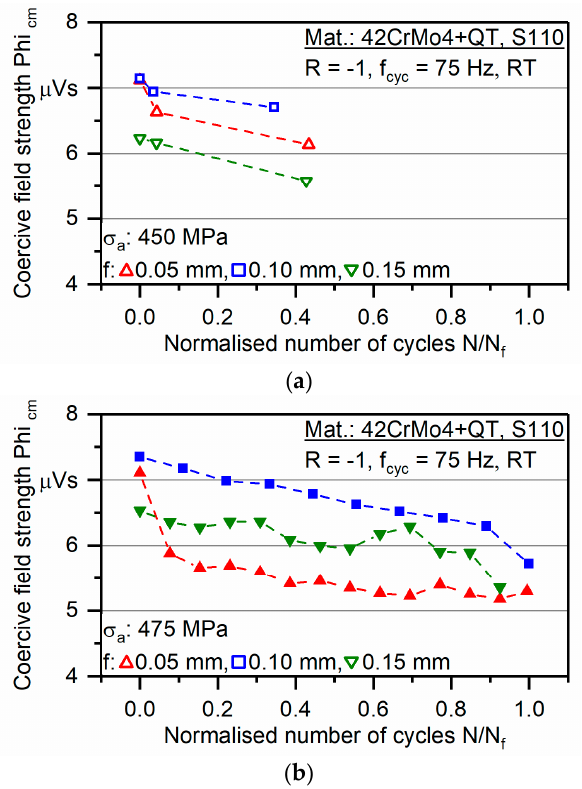
Figure 12. Coercive field strength versus the normalised number of cycles for constant amplitude tests with S110 specimens and amplitudes ( a ) 450 MPa; ( b ) 475 MPa. When the coercive field strength is also normalised on the 10 4 cycles value, a quadratic relationship between the coercive field strength and the proceeding fatigue damage can be observed for all investigated load amplitudes and all feed rates, whereby the best correspondence can be seen for the feed rates 0.05 mm and 0.10 mm. This relationship can be described with the following Equation (1): (cid:2870) (cid:3017)(cid:3035)(cid:3036) (cid:3278)(cid:3288) (cid:3017)(cid:3035)(cid:3036) (cid:3278)(cid:3288),(cid:3117)(cid:3116)(cid:3120) = 1 − 0.174 (cid:3015) (cid:3015) (cid:3281) + 0.048 (cid:3436) (cid:3015) (cid:3015) (cid:3281) (cid:3440) . (1) The decreasing coercive field strength can be correlated to relaxing compressive residual stresses. The stresses decrease according to the magnitude of the initial stresses and the applied load [10]. In consideration of the XRD measurements of the initial state, the specimen condition after first applied load cycles is much more significant than the initial state. Moreover, the normalisation of the coercive field strength Phi cm as a micromagnetic parameter and the number of cycles as lifetime state allows a load- and material-independent estimation of the fatigue damage (Figure 13).